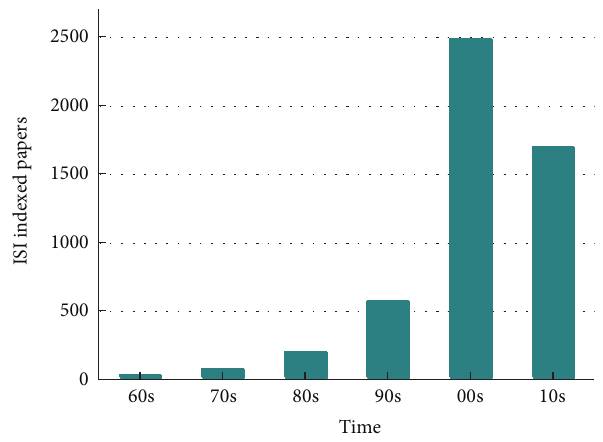
Figure 1: ISI indexed papers in the past